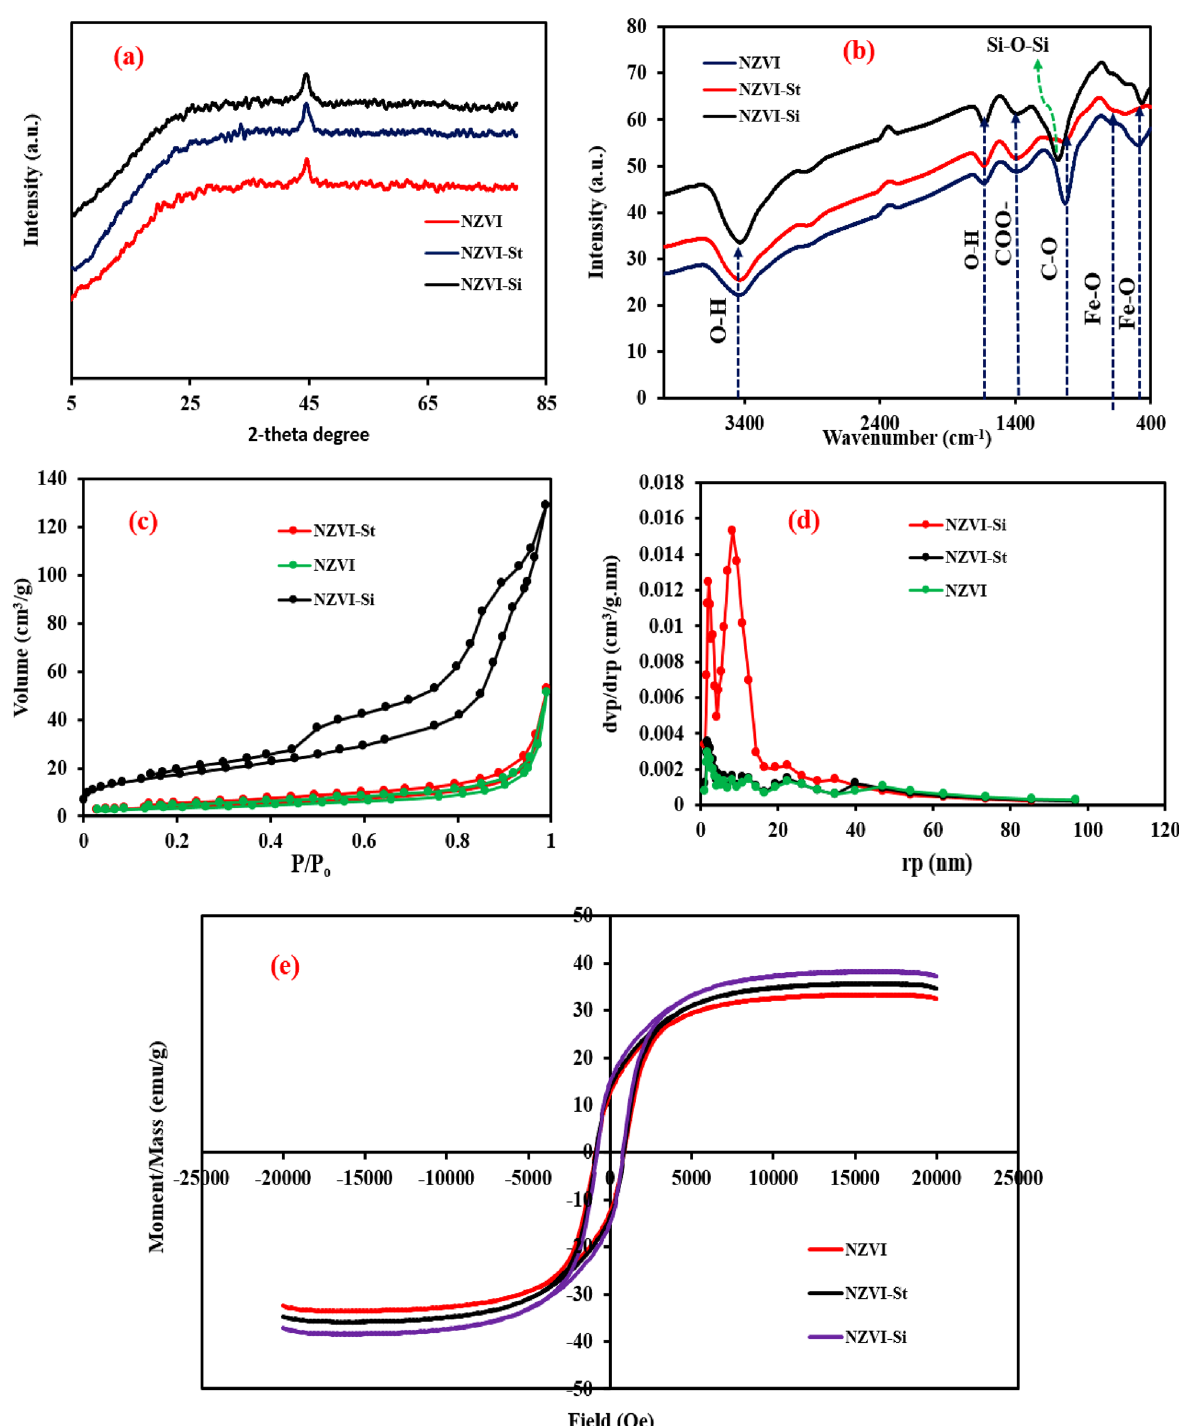
Figure 4. ( a ) XRD patterns; ( b ) FTIR spectra; ( c ) adsorption–desorption isotherms; ( d ) pore size distribution and ( e ) VSM of NZVI, NZVI-St and